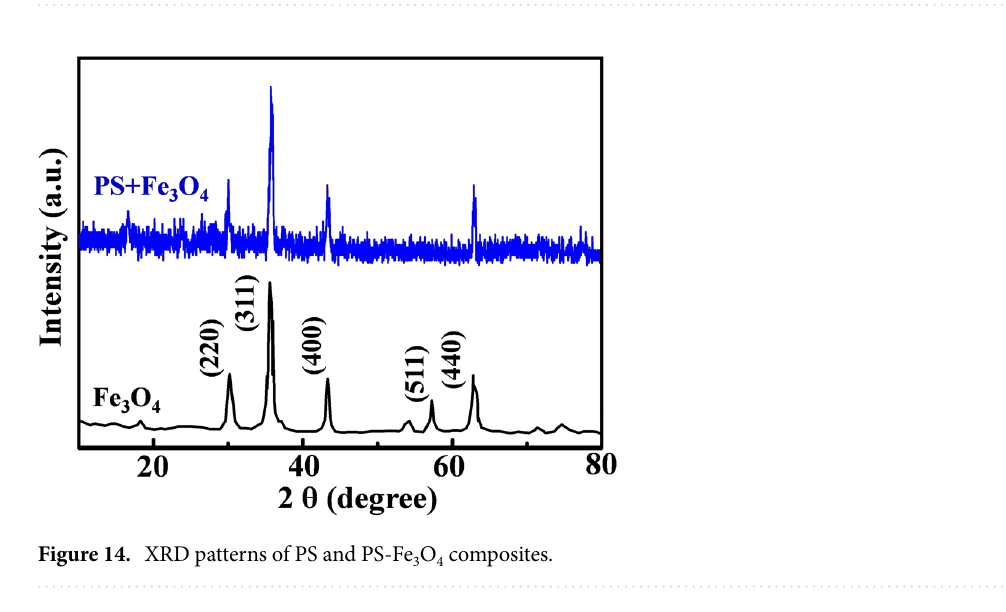
Figure 13. Patterned architecture with orthogonally laid fibrous strips.